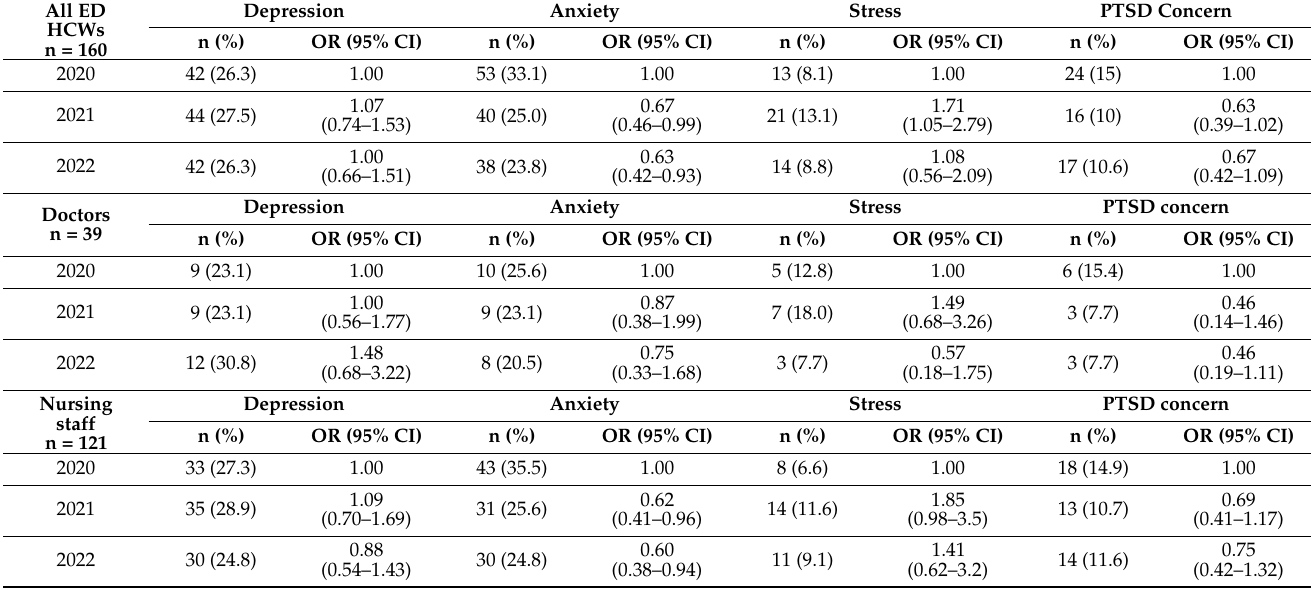
Table A6. Prevalence of each MHO amongst ED HCWs who participants in all three surveys (n =